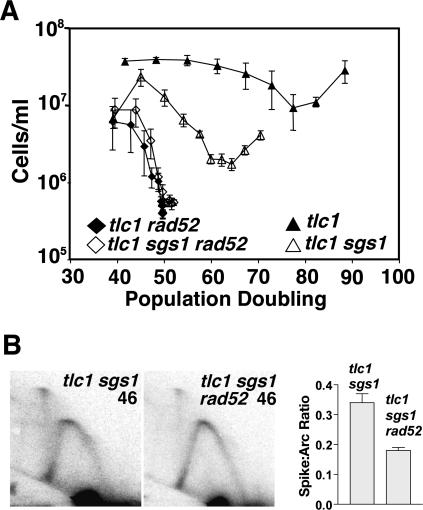
Dependence of Senescence and X-Structures on RAD52
(A) Effect of sgs1 and full-ORF rad52 deletion mutations on the senescence of tlc1 mutants. Senescence rates were measured in liquid assays for spore products of the indicated genotypes derived from a diploid that was triply heterozygous for tlc1, sgs1, and Δrad52 mutations. Each value is the mean and standard error of three or four independent spore products. Similar results were obtained using an est2 deletion allele instead of the tlc1 mutation (unpublished data).(B) Left and middle: DNA was isolated from tlc1 sgs1and tlc1 sgs1 rad52 mutants at indicated PD and analyzed as in Figure 1B. Right: mean spike:arc ratios for two independent pairs of tlc1 sgs1 and tlc1 sgs1 Δrad52 cultures were 0.34 ± 0.03 and 0.18 ± 0.01, p < 0.04; a second 2DGE of the same two independent pairs of cultures gave similar results. Note that in order to compare PD-matched samples, tlc1 sgs1 cultures were used prior to the development of high X-structure levels; comparisons made between cultures near the end of senescence show a larger effect of rad52 deletion (cf. Figure 1B, tlc1 sgs1 PD60).